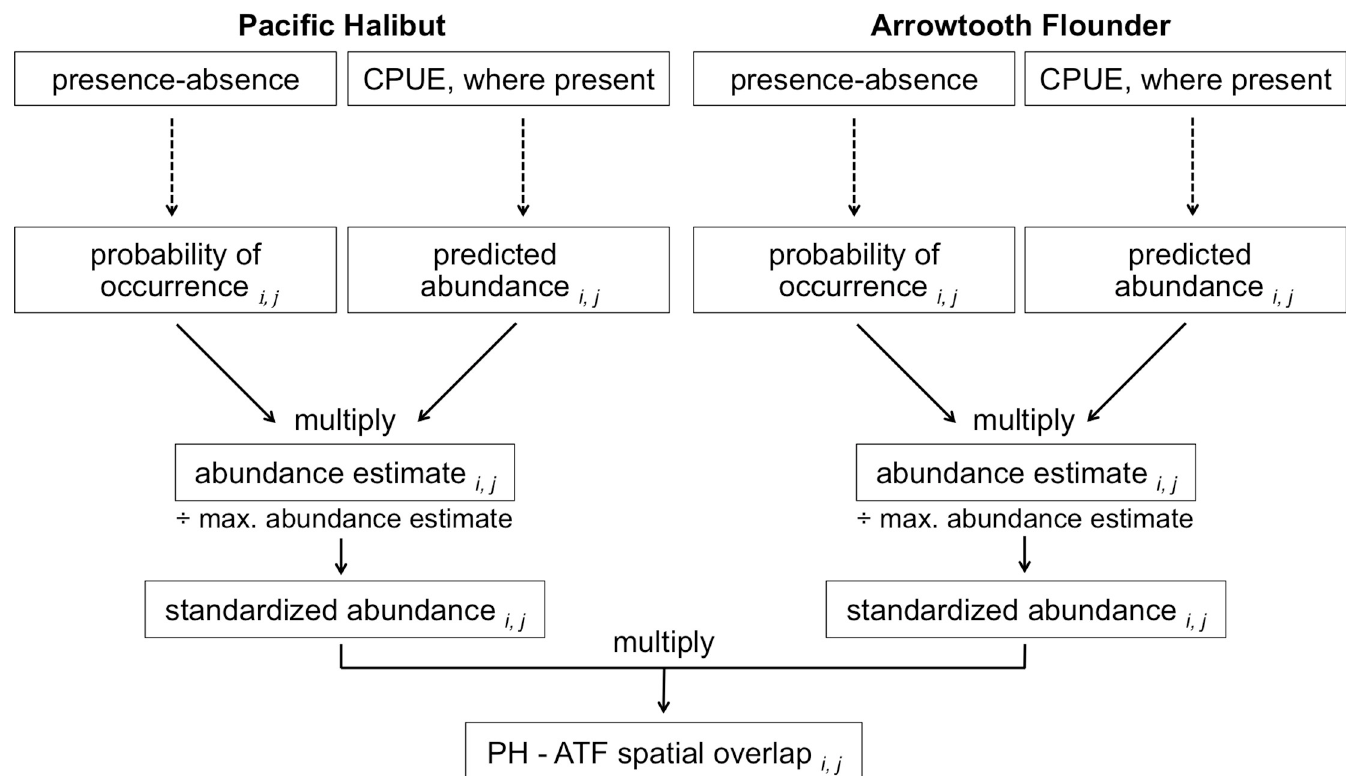
Fig 2. Analytical framework used to quantify spatial overlap between Pacific Halibut and Arrowtooth Flounder. First, bottom trawl survey data from the Gulf of Alaska and generalized additive models were used to separately quantify presence-absence and catch-per-unit-effort (CPUE; number per ha) as a function of survey year, tow location (latitude, longitude), depth, and bottom temperature. Model results were used to estimate the probability of occurrence and predicted abundance for Pacific Halibut or Arrowtooth Flounder in each combination of survey year i and uniform grid cell j . These predictions were multiplied to estimate abundance, which was then standardized by dividing each survey year-grid cell value by that species’ maximum across all years. Finally, standardized abundances for Pacific Halibut and Arrowtooth Flounder were multiplied to approximate spatial overlap in each survey year and grid cell. Analytical methods were modified from those described by Hunsicker et al . [32] and Shelton et al .